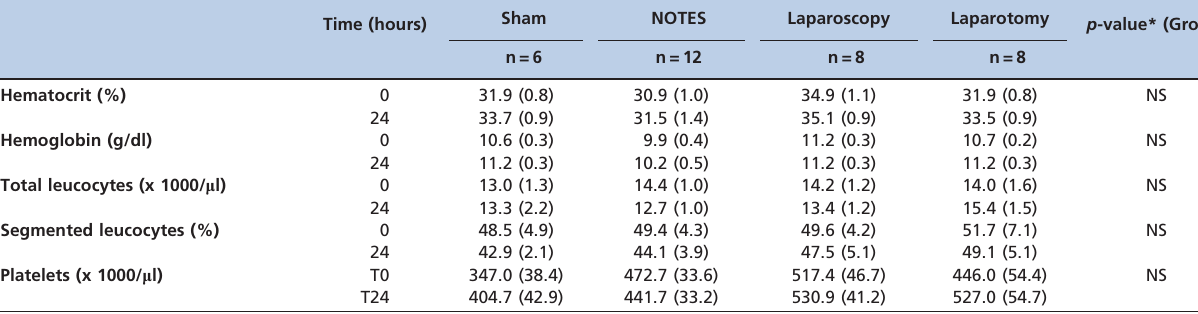
Table 3 - Complete blood count measurements at T0 and T24. Time (hours) Sham